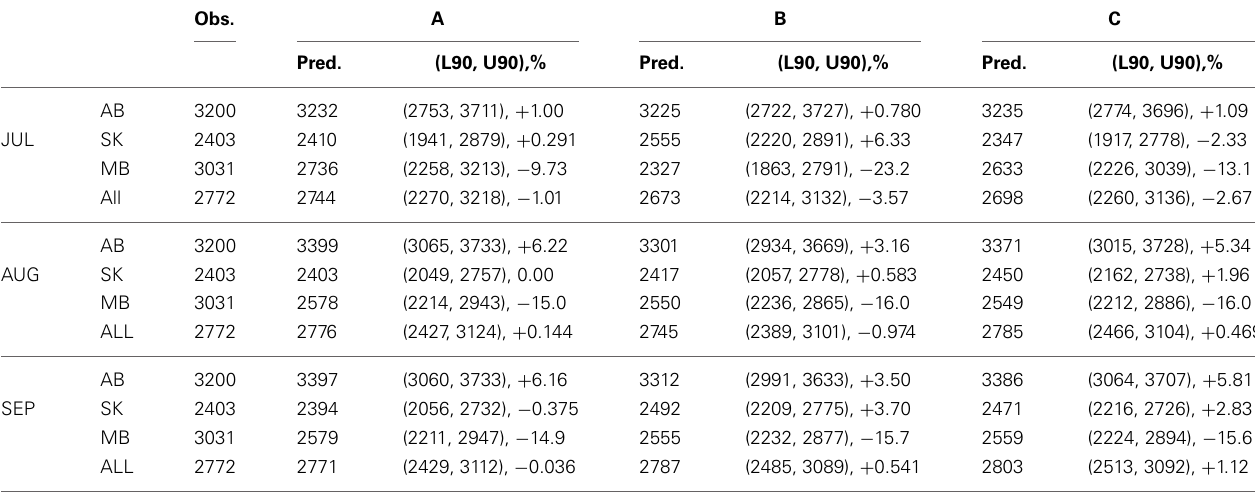
Table 3 | Forecasting of 2012 spring wheat crop yield (kg/ha) across the Canadian Prairie provinces (AB—Alberta, SK—Saskatoon, MB—Manitoba,